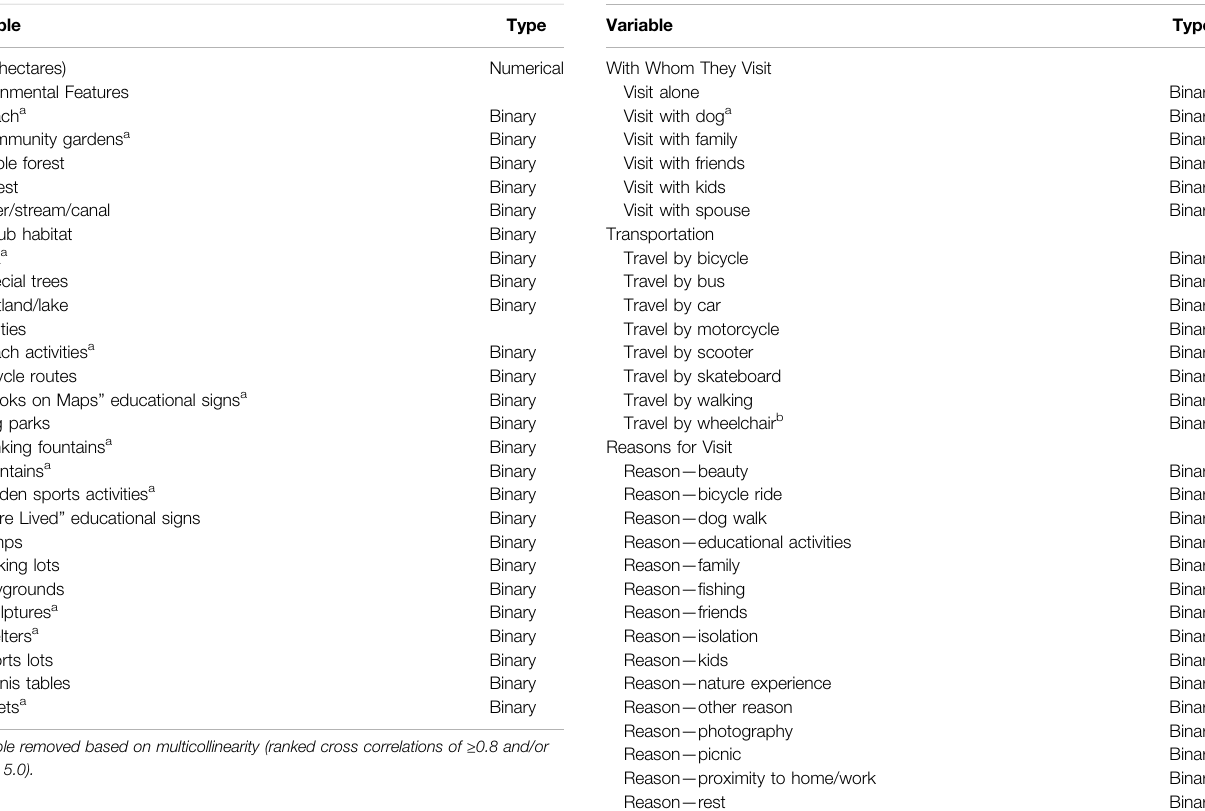
TABLE 2 | Survey variables describing the characteristics of participants ’ urban nature site